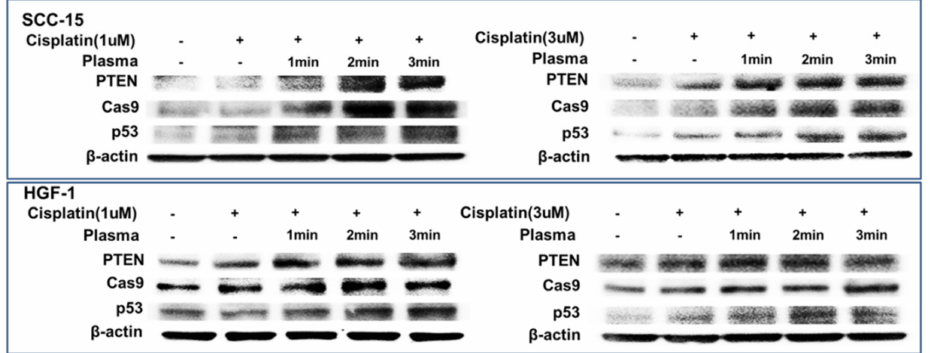
Figure 8. Western blot for the analysis of apoptosis behavior of cells. SCC-15 cells and HGF-1 cells were treated with cisplatin and CAP as described in Figure 4. Cells treated with cisplatin / CAP were then used to analyze tumor suppressor proteins and apoptosis proteins using Western blotting.